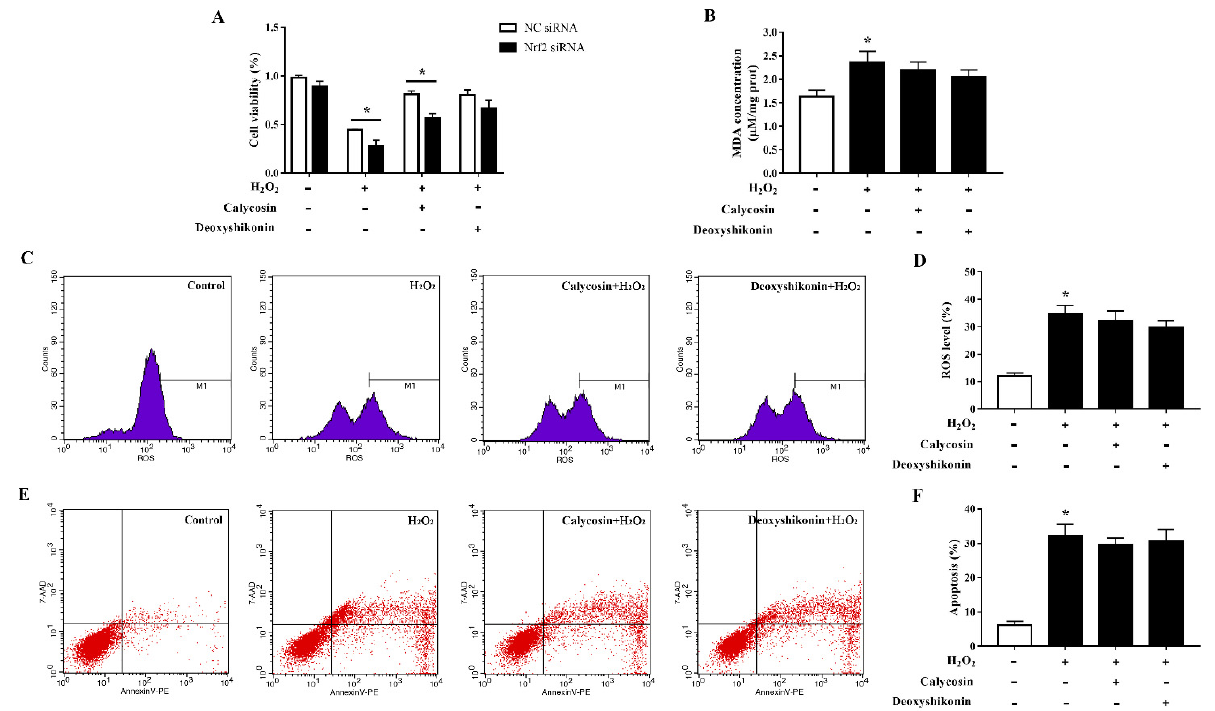
Figure 9. Effects of the hit compounds on H 2 O 2 -induced oxidative stress in Nrf2-knockdown IPEC-J2 cells. IPEC-J2 cells were transfected with Nrf2 siRNA or negative control siRNA and the efficiency of Nrf2 knockdown was confirmed by RT-qPCR. Nrf2-knockdown and control cells were treated, and not treated, with calycosin or deoxyshikonin for 24 h, then with 1000 μ M H 2 O 2 for 4 h. Nontreated cells served as a control. ( A ) Cell viability as measured using the CCK-8 assay. The results were normalized to negative control siRNA-transfected cells not treated with H 2 O 2 and compounds. ( B ) MDA concentrations as determined using an MDA assay. ( C ) Flow-cytometric analysis of ROS. ( D ) Quantification of ROS using based on flow cytometry data. ( E ) Flow-cytometric analysis of apoptotic cells. ( F ) Quantification of apoptotic cells based on flow cytometry data. Data represent the mean ± SEM of three independent experiments. The means of two groups were compared using Student’s t -tests. * p < 0.05 vs. nontreated control